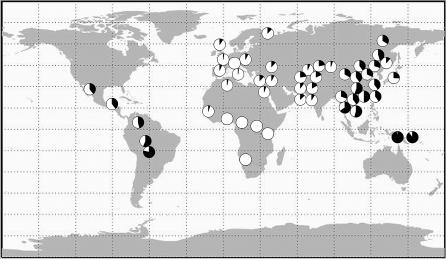
Worldwide Frequency Distribution of APOBEC3B DeletionGenotype frequencies from analysis of the HGDP (51 populations, Table S3) are overlaid on a map of the world. The deletion (black area of pie chart) and insertion frequency (white) are depicted.